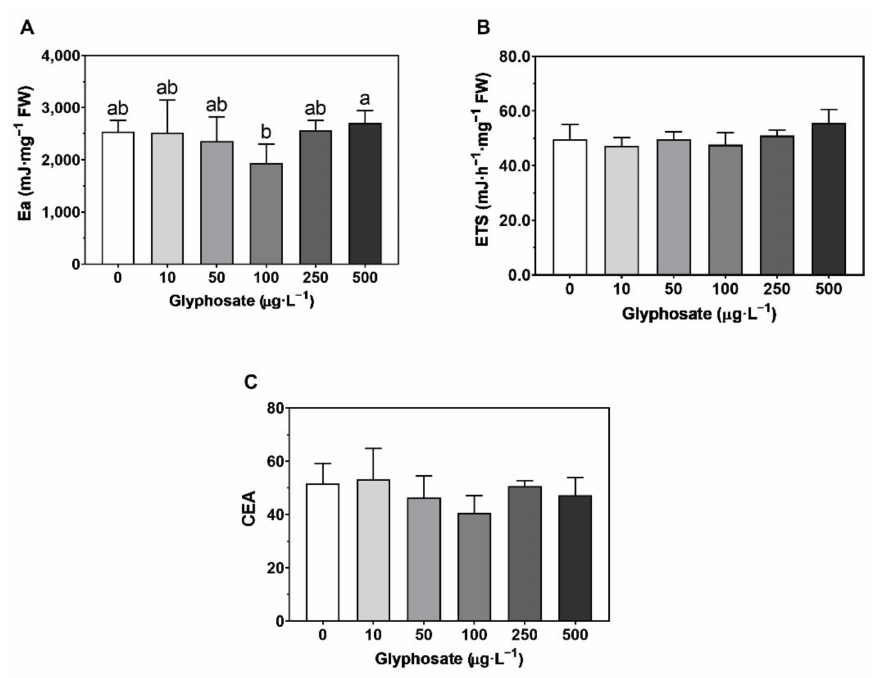
Figure 8. Energy balance: ( A ) energy available [Ea]; ( B ) energy consumption rate [ETS]; ( C ) cellular energy allocation [CEA]) in Ulva lactuca following a 48-h exposure to glyphosate-based herbicide formulation in different concentrations (mean ± s.d., n = 5, different letters indicate significant differences at p < 0.05).